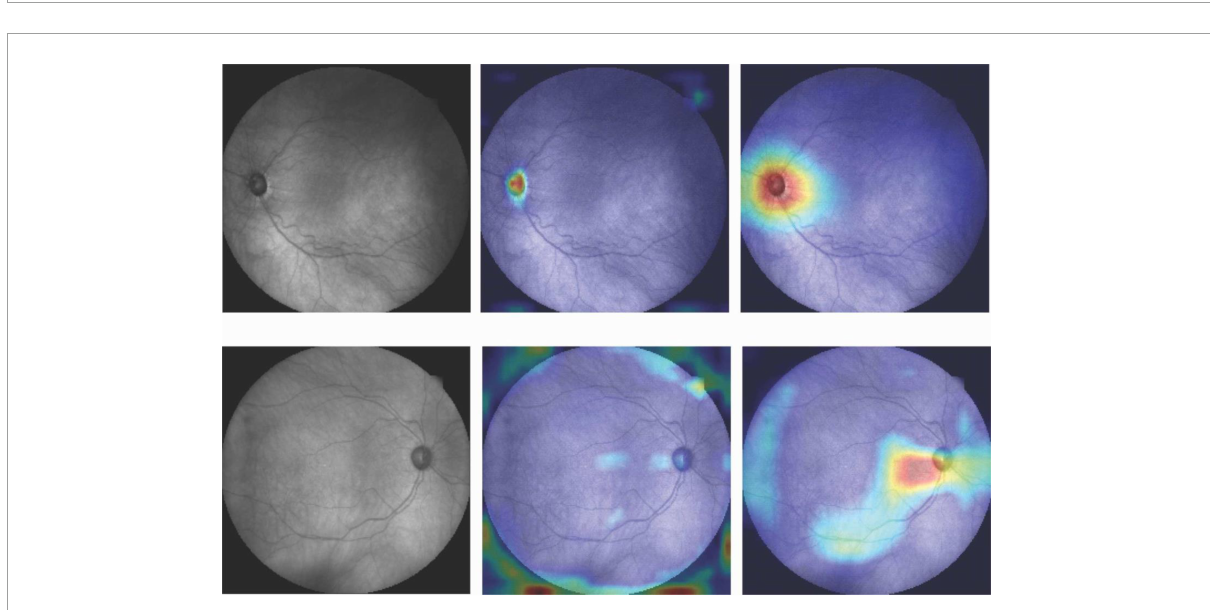
FIGURE4 Fundus photographs and corresponding CAMs at two different convolutional layers. Top row: Correct prediction. Bottom row: Incorrect prediction. Highlighted regions were more important for the model to make